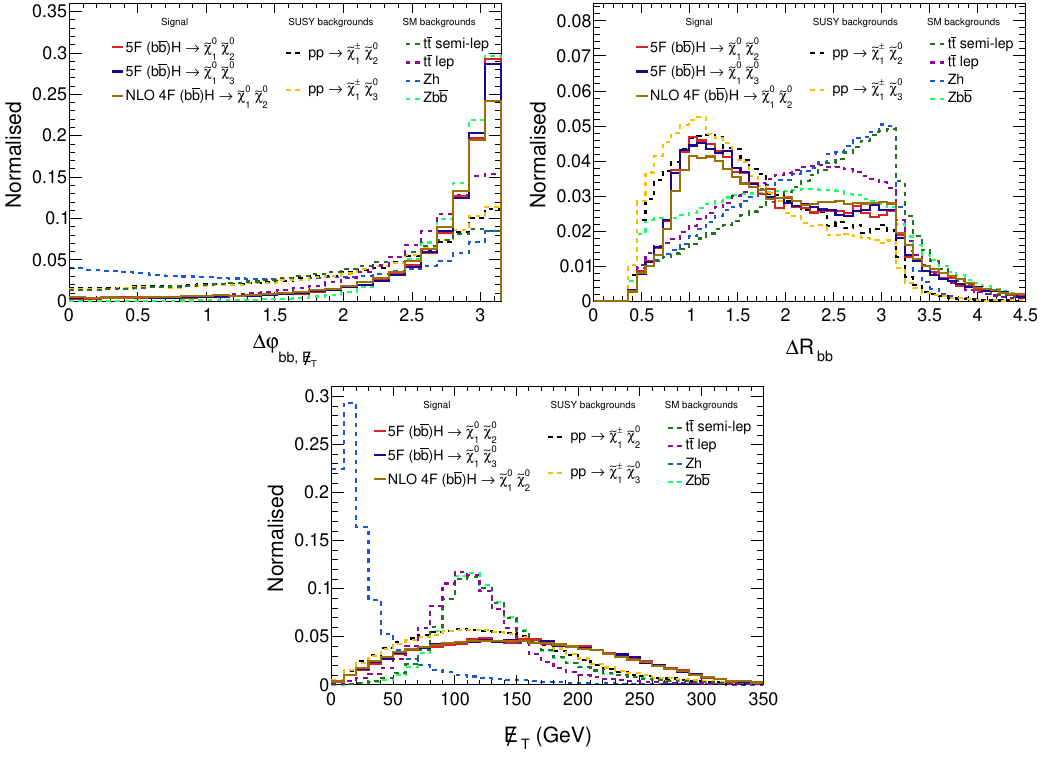
Figure 17. The normalised distributions of ∆ φ for the b ¯ b + / E final state after the basic trigger cuts for the BP 1 T